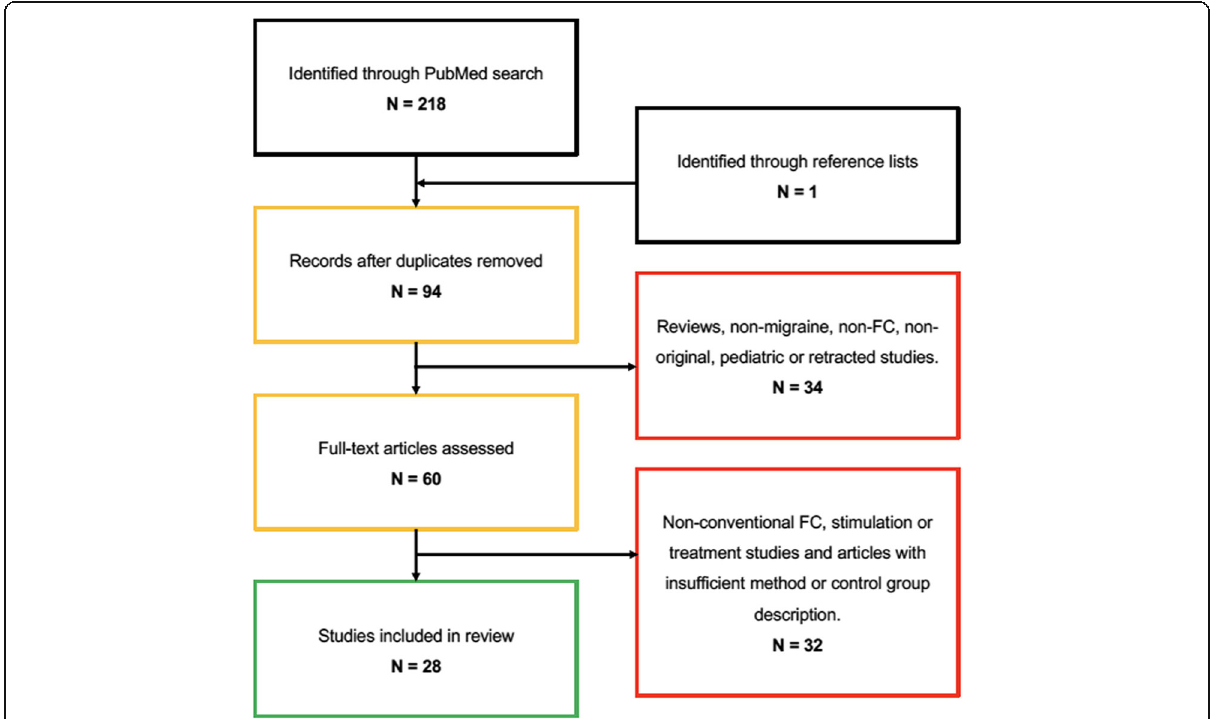
Fig. 1 Flow chart of the literature search on functional connectivity (FC) studies in